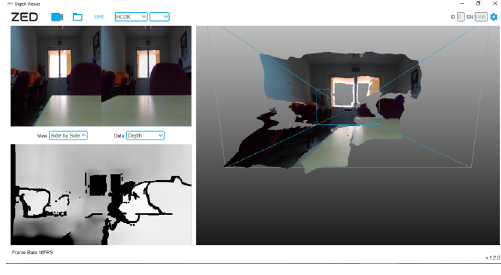
Figure 2. ZED Depth Viewer